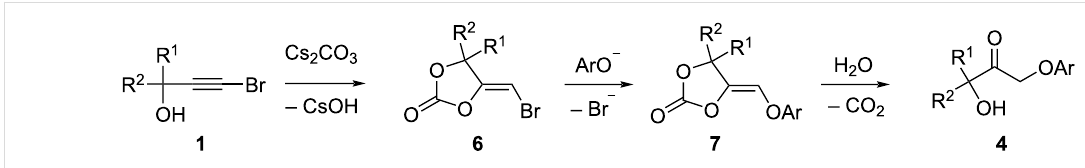
Scheme 7: A plausible mechanism for the formation of phenoxyhydroxyketone 4 .